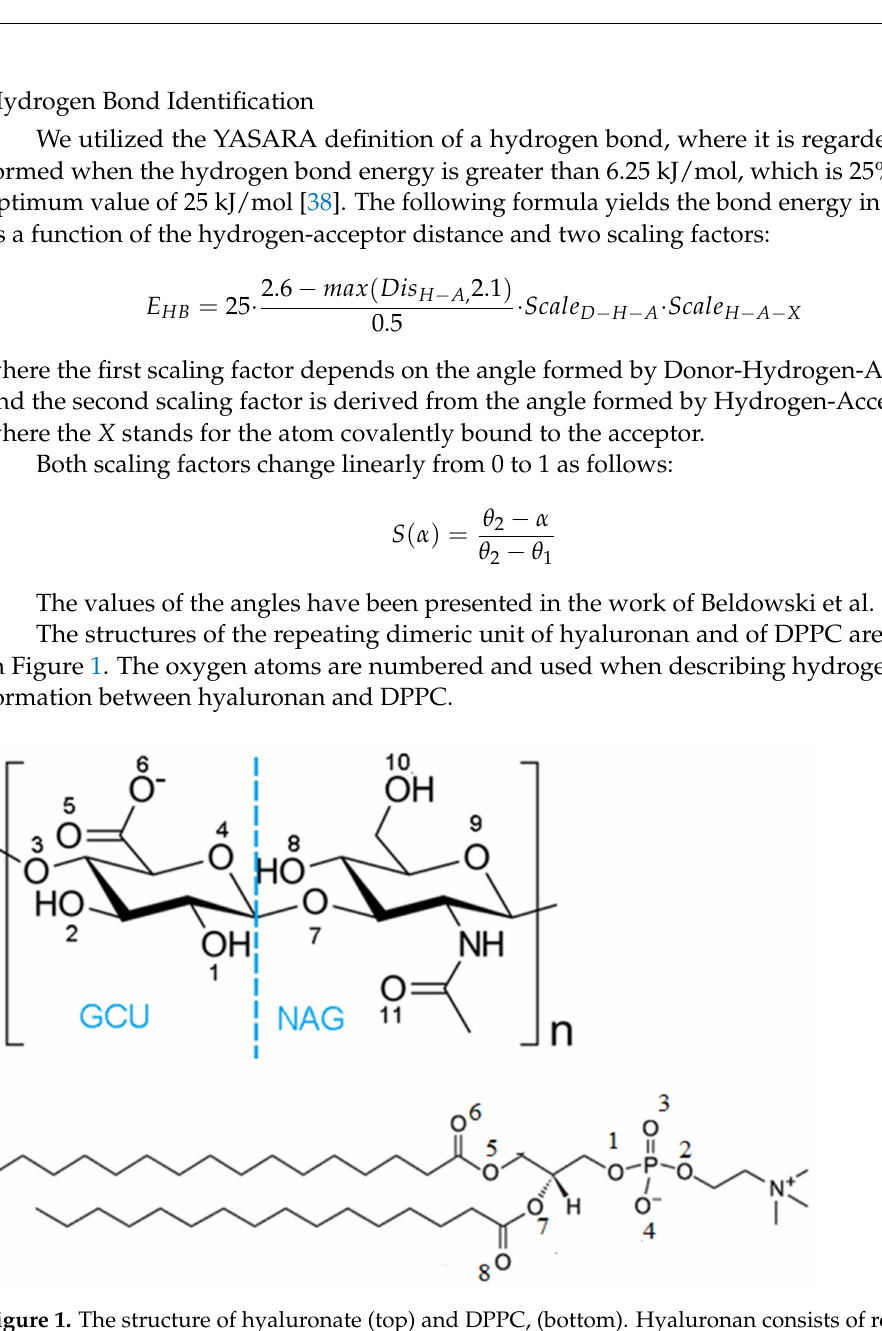
Figure 1. The structure of hyaluronate (top) and DPPC, (bottom). Hyaluronan consists of repeating units of D-glucuronic acid, GCU, and N-acetyl-D-glucosamine, NAG. Hyaluronan predominantly exists in anionic hyaluronate form at the pH found in the synovial fluid where the hydrogen on O6 is released. The numbers are assigned to the oxygen atoms and used when discussing hydrogen bond formation between specific